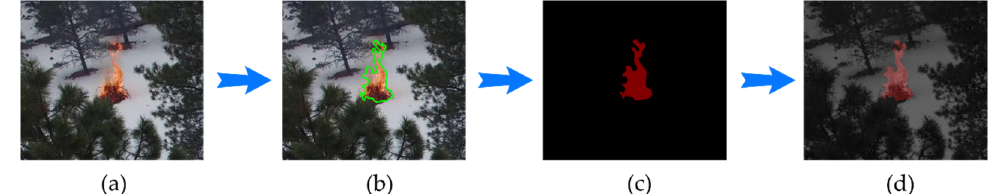
Figure 2. Material of annotation result and ground truth for training: ( a ) raw image; ( b ) annotation of the forest-fire target; ( c ) ground truth label; and ( d ) raw image with the extracted mask.